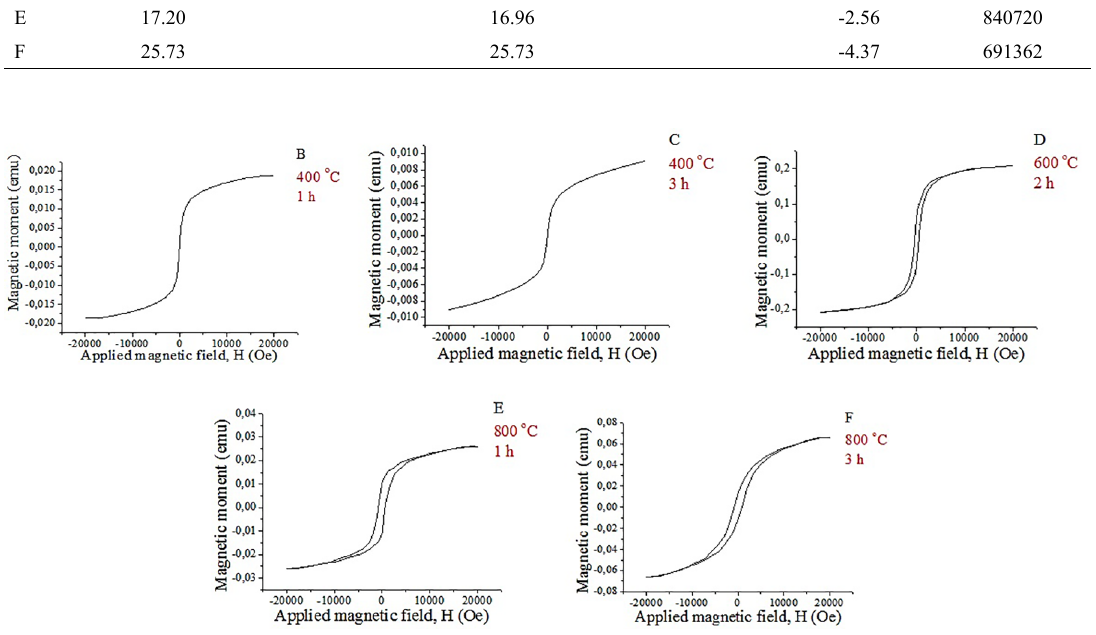
Figure 7. Magnetometric analysis of the samples treated in the N Table 3. Magnetometric analysis results of the samples treated in the N Sample M ( × 10 -3 s